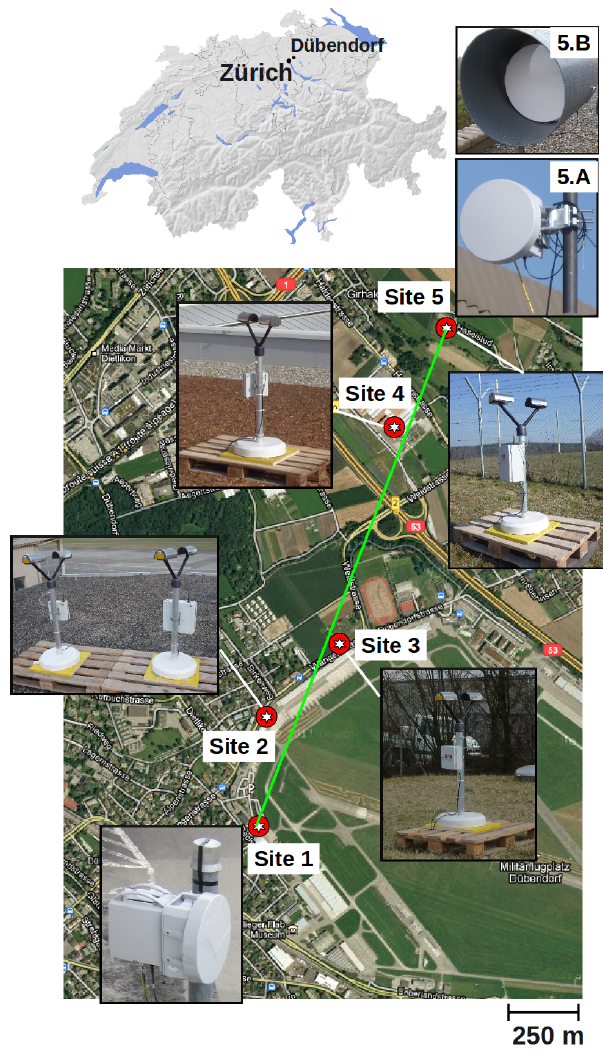
Fig. 1. Experimental set-up deployed in D¨ubendorf, Switzerland. The Disdrometers are located at sites 2 (2 collocated stations), 3, 4 Fig. 11. Experimental set-up deployed in D¨ubendorf, Switzerland. and 5. The rain gauges at sites 2, 4 and 5. Pictures 5.A and 5.B show The Disdrometers are located at sites 2 (2 collocated stations), 3, 4 the MWL (at site 5) with (respectively without) the rain and 5. The rain gauges at sites 2, 4 and 5. Pictures 5.A and 5.B show the MWL (at site 5) with (respectively without) the rain shields.